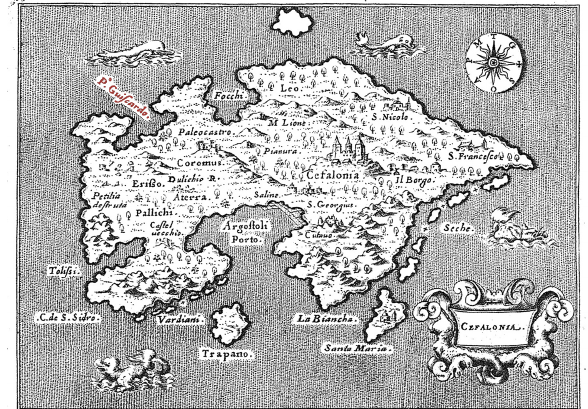
Figure 8 . T. Porcacchi, L'isole più famose del mondo, Heredi di Simon Galignani, Venice, 1590, p. 121.